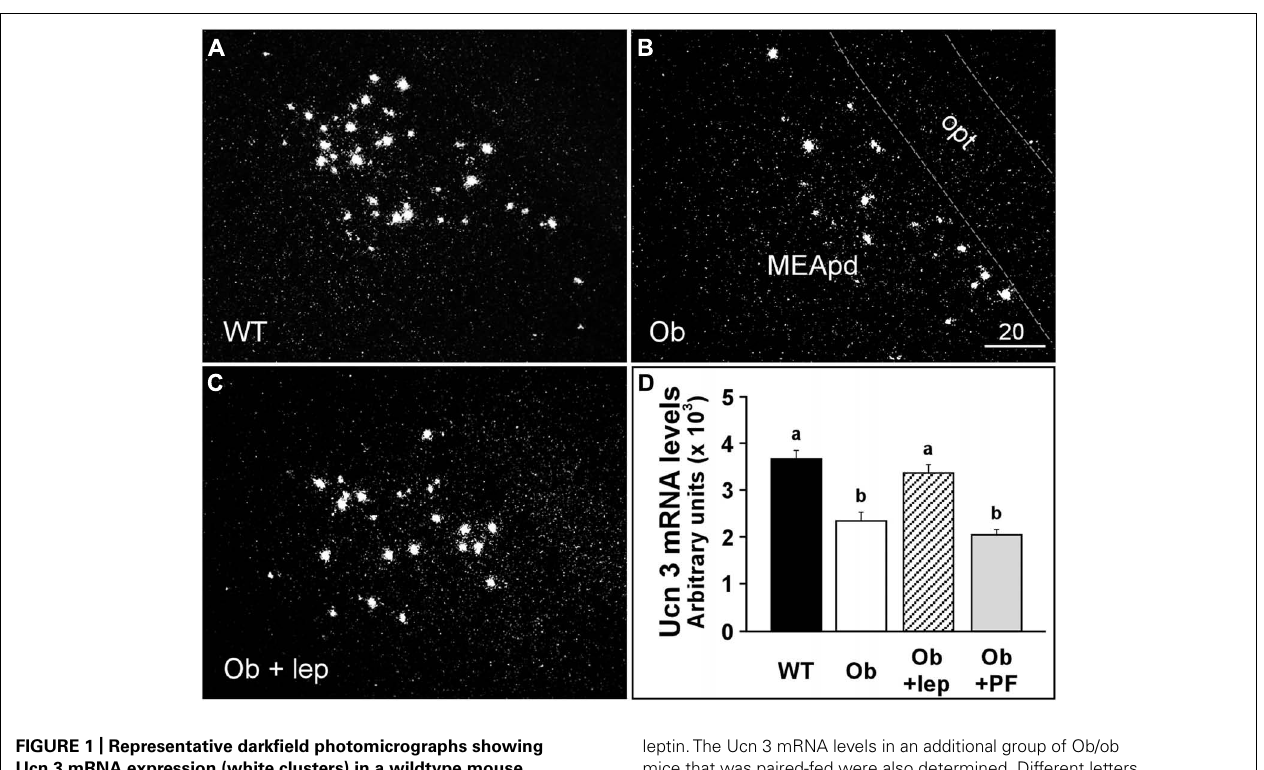
leptin.The Ucn 3 mRNA levels in an additional group of Ob/ob mice that was paired-fed were also determined. Different letters represent statistical significance: p < 0.05. MeApd, medial nucleus of amygdala, posterodorsal part; opt, optic tract. Scale bar = 20 μ